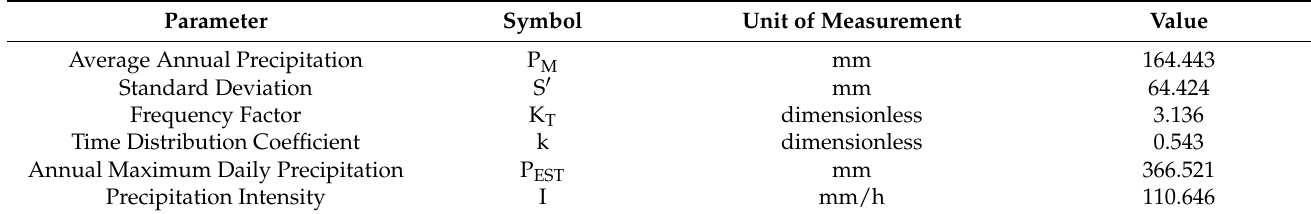
Table 2. Precipitation parameters.